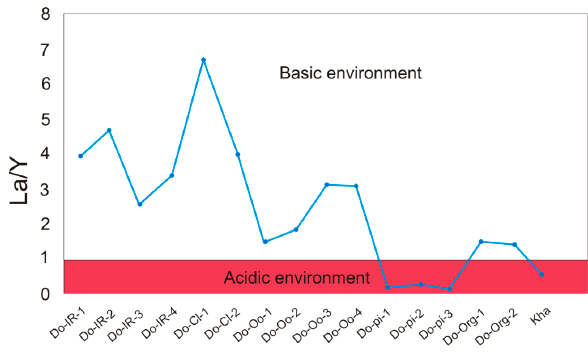
Figure 10. La/Y ratios from the Khaneh–Kat Formation and bauxite samples of the Dopolan deposit [13,55].